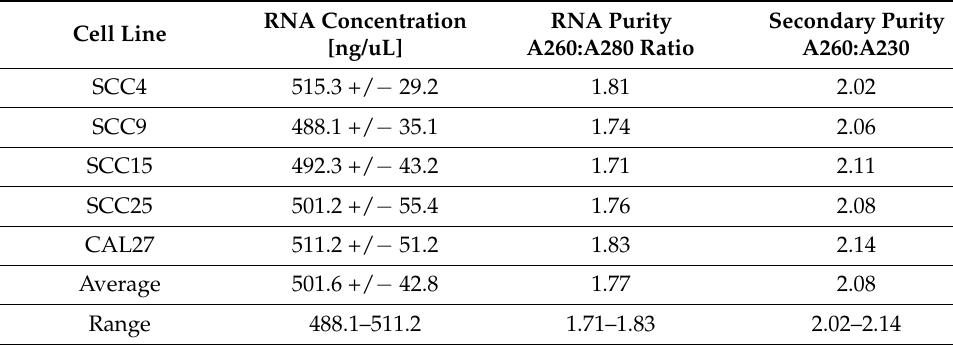
Table 1. Analysis of RNA concentration and